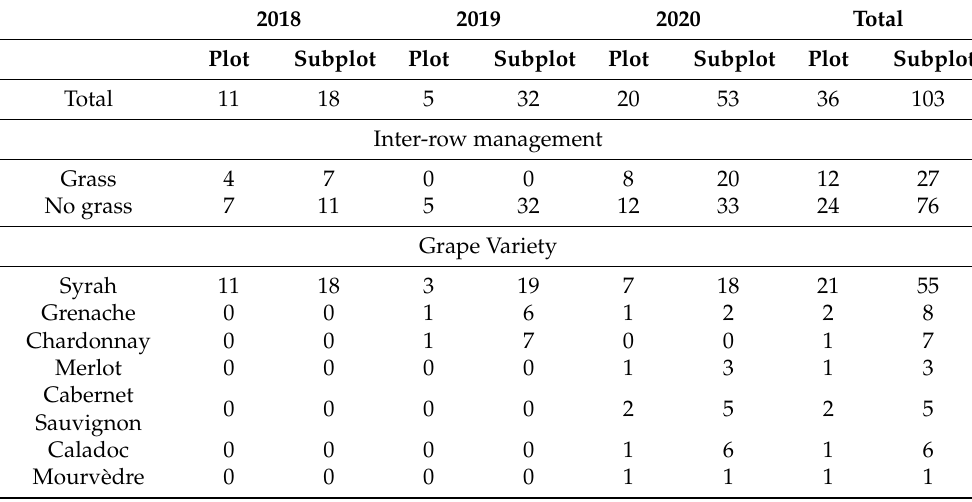
Figure 4. Example of 2 subplots in a plot and location of 10 SWP measurements in a subplot. The number and location of the subplots are chosen according to (1) the S2 20 m pixel grid in order to have a good representation of the variability in the entire pixel, (2) plot soil and/or vegetation variability as reported by agronomic expert or vine-growers and (3) the time needed to perform the SWP measurements in the field. Vis for SWP measurements were selected in order to have a good representation of the entire pixel and according to the rows orientation inside the pixel. Table 2. Number of grass, ungrass and total plot and subplot for each year and their grape